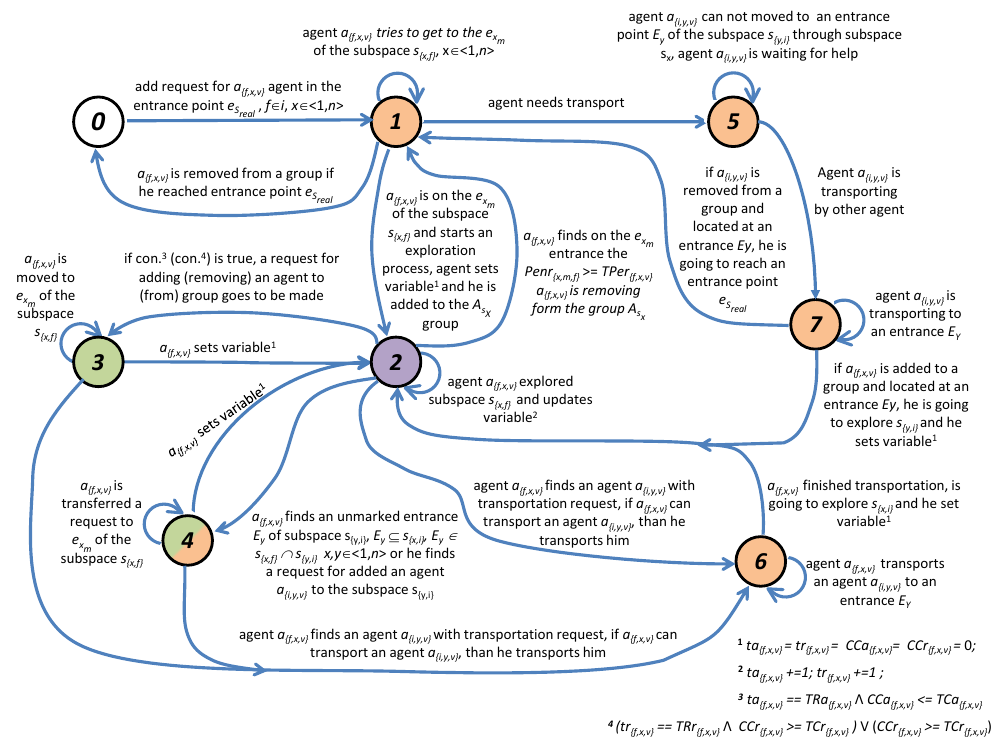
Figure 2. Pseudo-state diagram of the agent’s entire decision making process (green represents population management behavior, purple represents exploration/monitoring behavior, and orange represents transportation